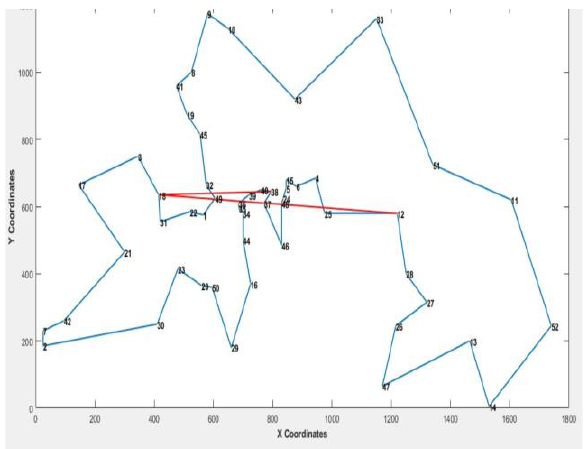
Fig 14. Berlin52 path with constraints cities 12,18 and 38